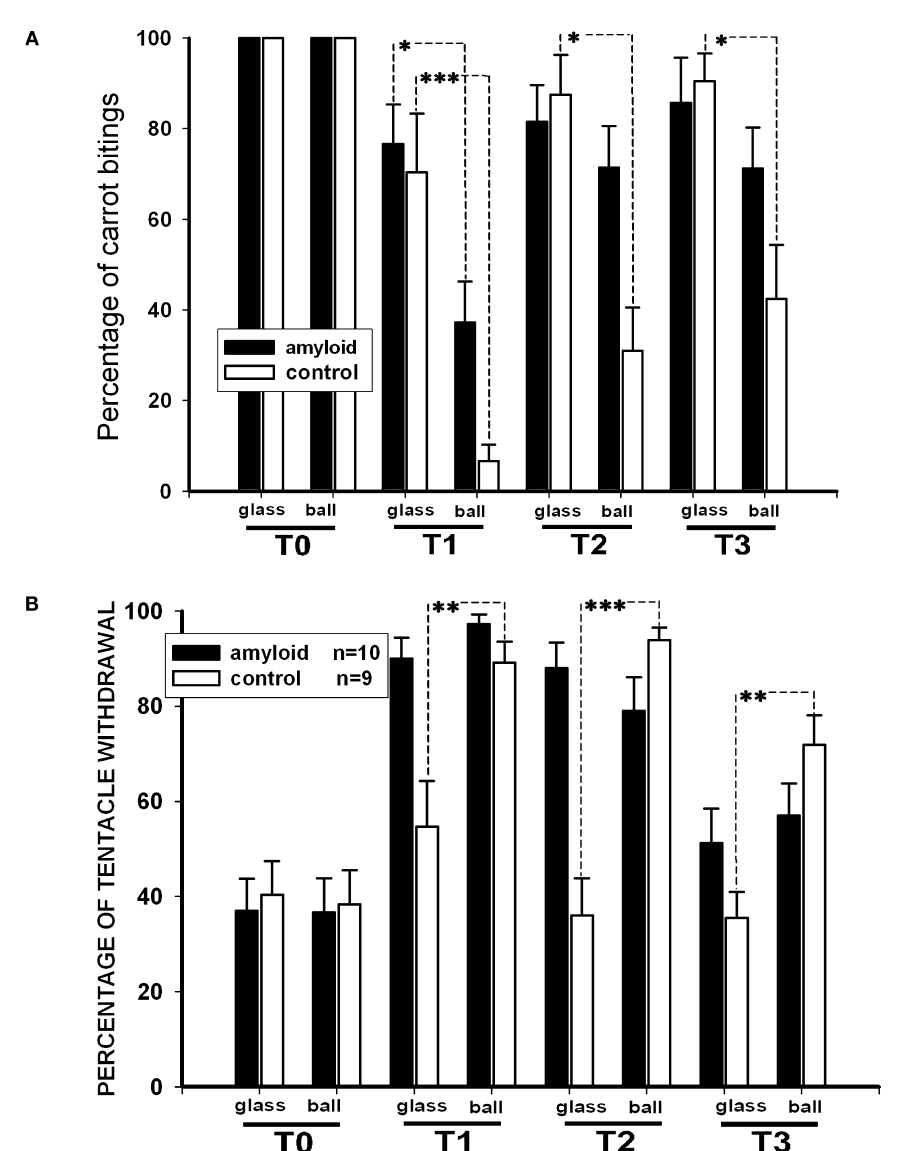
Figure 5 | Changes in quantity of food grasping events (percentage of food presentations number) due to learning, context memory test. (A) Number of carrot bites by control snails ( n = 15) and β AP-injected snails ( n = 17) in two contexts: on the ball (reinforced context) and on the glass. Testing was performed before learning (T0), after 2 (T2), 5 (T2) and 14 days (T3) of rest after learning. Y -axis – number of carrot grasps (percentage of presentations), averaged for each snail. (B) Testing of context memory in associatively trained snails; tentacle withdrawal in control snails ( n = 9) and β AP-injected snails ( n = 10) was estimated in two contexts: on the ball (reinforced context) and on the glass. Testing was performed before learning (T0), after 2 (T2), 5 (T2) and 14 days (T3) after learning. Y -axis – amplitude of tentacle withdrawal, percentage of maximal length. * p < 0.05, ** p < 0.01, *** p <